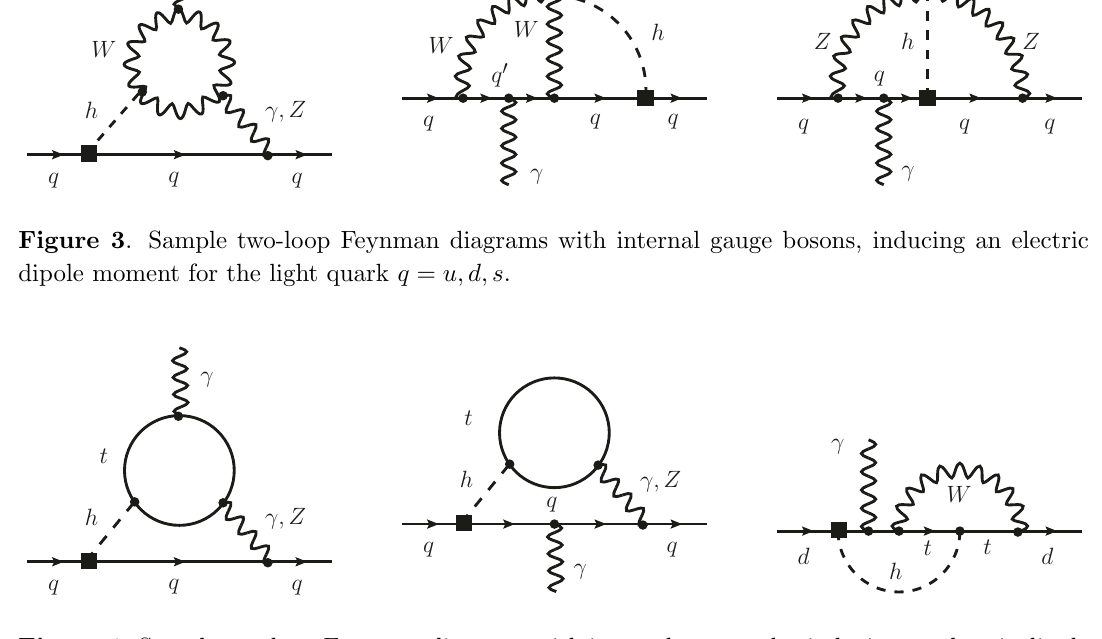
Figure 4 . Sample two-loop Feynman diagrams with internal top quarks, inducing an electric dipole moment for the light quark q = u; d; s . Left panel: the classic \Barr-Zee" diagrams. The diagrams with an internal Z boson give a substantial contribution for external down quarks. The sum of diagrams of the form shown in the middle panel vanishes (the same is true for the corresponding bosonic diagrams). Right panel: this class of diagrams with an internal top-quark line is paramet- rically suppressed by small CKM matrix elements and has been neglected in our